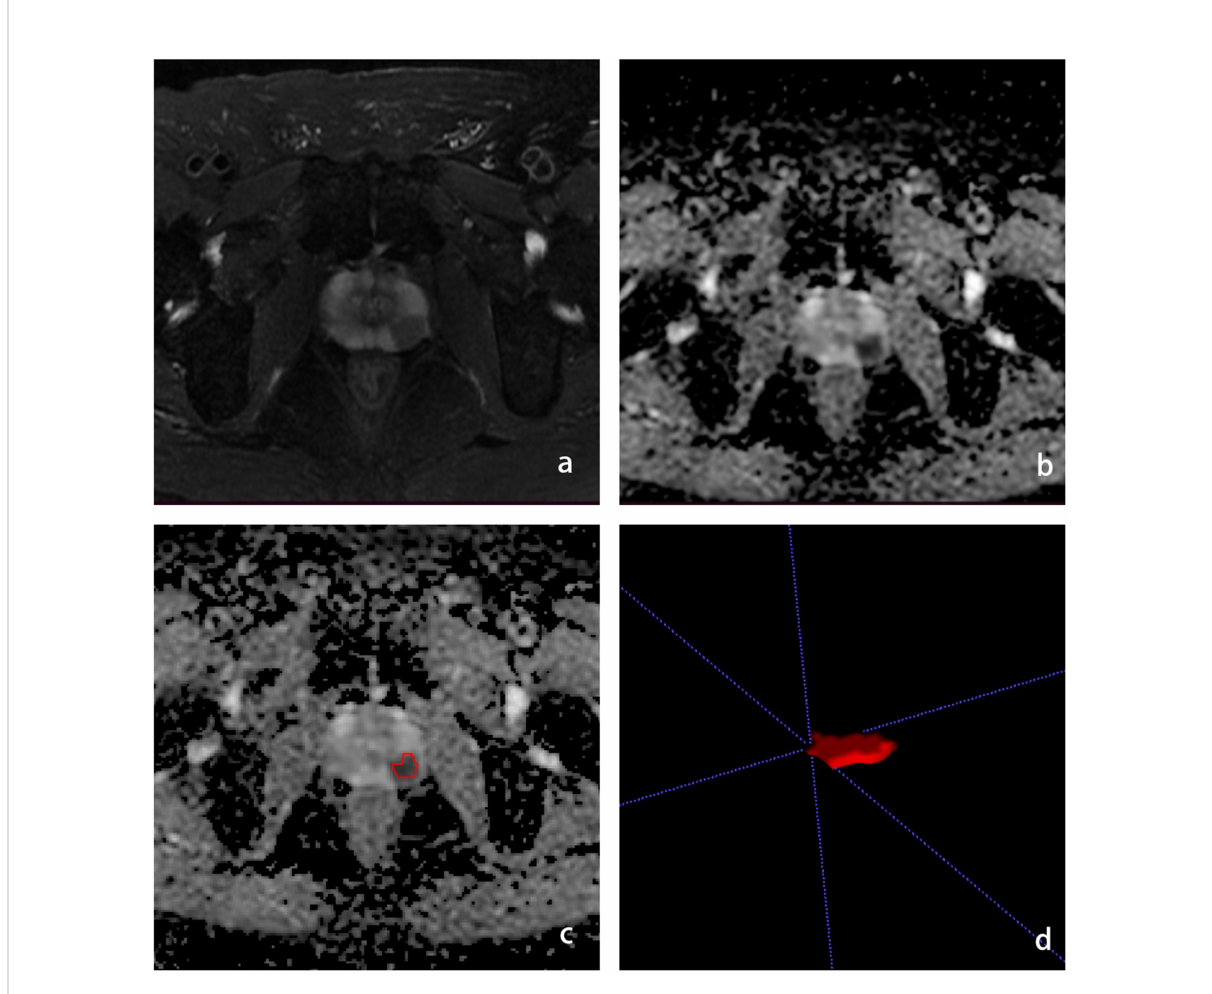
FIGURE 2 Schematic diagram of the ROI outline. (A) is the T2WI sequence with PCa in the left peripheral band, (B) is the ADC sequence with the cancer foci showing low signal, (C) is the ROI outline, (D) is the generated